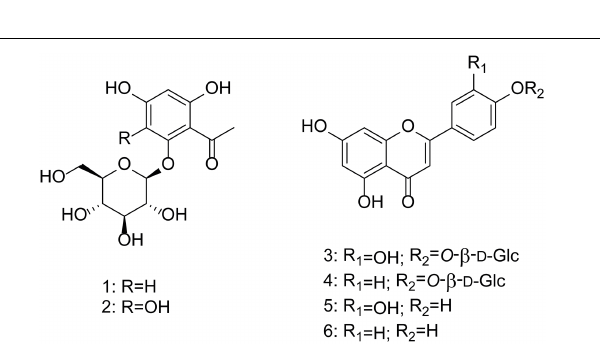
FIGURE 1 | HPLC chromatogram of Lawsonia inermis L. leaves F5 extract at 280 nm acquired in the HPLC-HRMS-SPE-NMR mode.